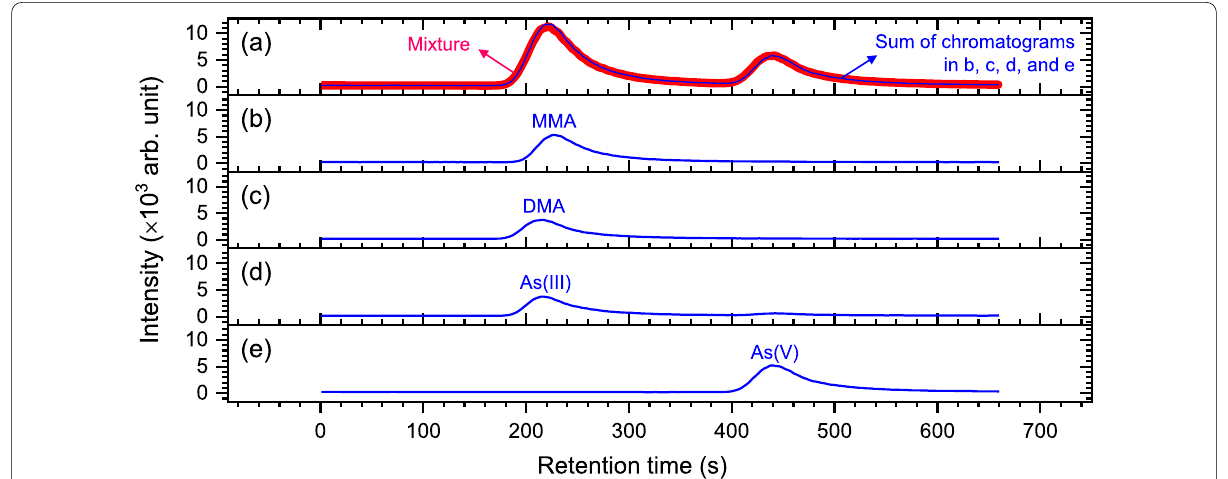
Fig. 1 Chromatograms of Arsenic species. a The chromatogram of the mixture solution (red) and the sum of the chromatograms in (b–e) (blue), and the chromatograms of the standard solutions of b MMA, c DMA, d As(III), and e As(V). In the mixture solution, the concentrations of As from each species were equally set to 5 μg/kg. Each standard solution contained 5 μg/kg of